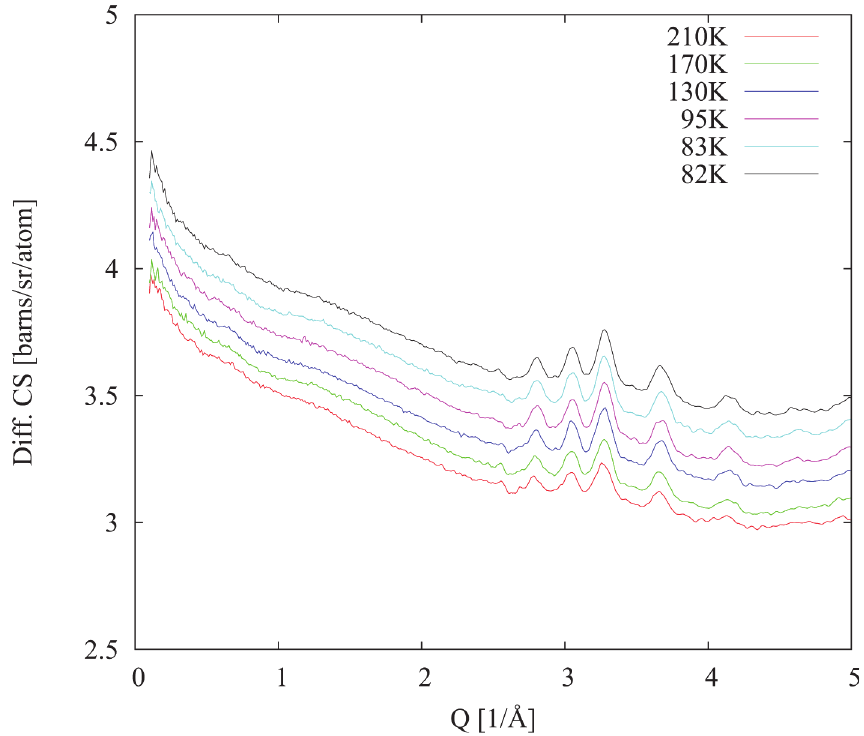
Fig 5. Differential cross sections for fully protiated sample. Cooling after heating scan.